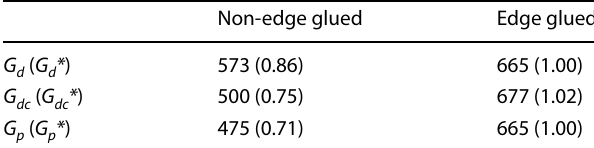
Table 1 Shear modulus, G [unitless] for the simulated